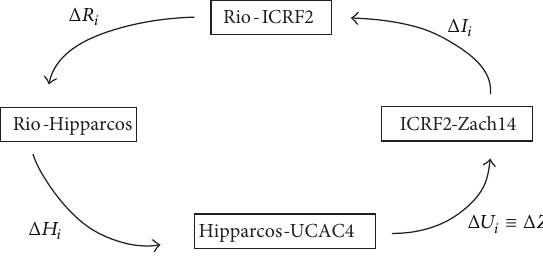
Figure 1: Fixed point iterative process (see explanation in